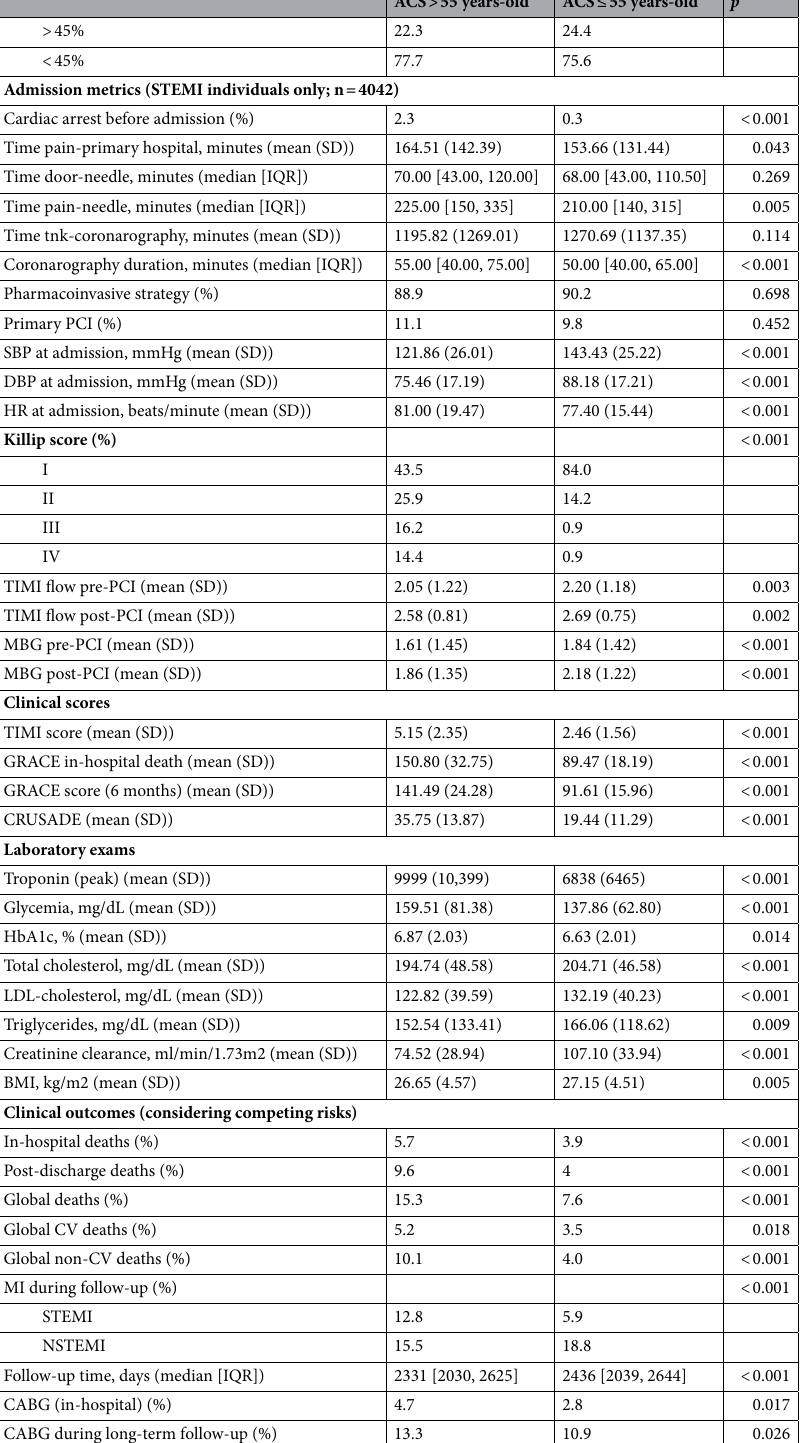
Table 1. Baseline characteristics and clinical outcomes of individuals with premature acute coronary syndrome (ACS, ≤ 55 years old) and older subjects with ACS (> 55 years old). CABG Coronary artery bypass graft, CKD Chronic kidney disease, GFR Glomerular filtration rate (CKD-EPI), GPIIbIIIa Glycoprotein IIbIIIa, HbA1c Glycosylated hemoglobin, LDL-C Low-density lipoprotein cholesterol, LV Left ventricle, BMI Body mass index, NSTEMI Non-ST-elevation myocardial infarction, PCI Percutaneous coronary intervention, STEMI ST-elevation myocardial infarction, SBP Systolic blood pressure, DBP Diastolic blood pressure, HR Heart rate, CV